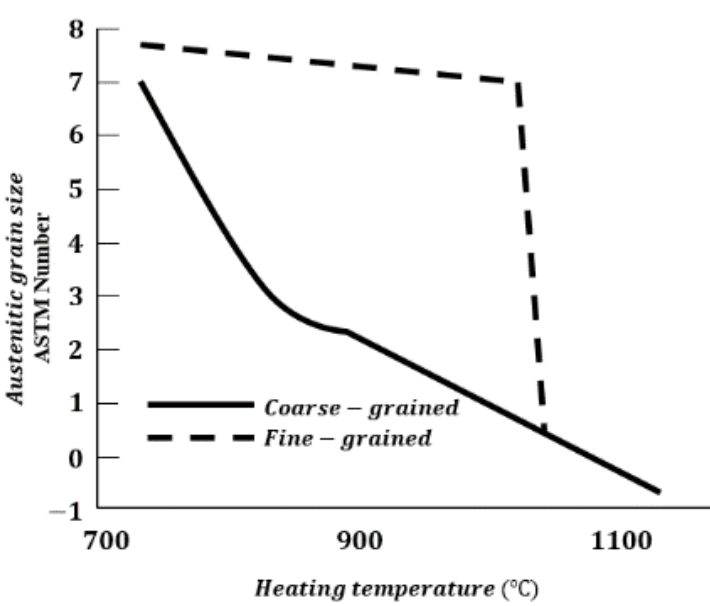
Figure 3. Austenitic grain size and ASTM number [17].